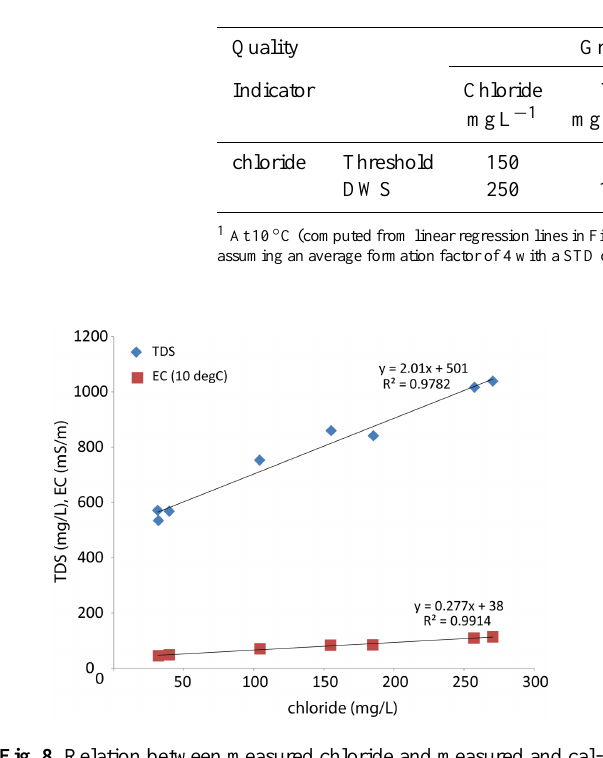
Table 8. Groundwater electrical conductivity (EC) and TDS content for the investigated chalk aquifer corresponding to the WHO and EU drinking water standard (DWS) for chloride of 250mgL − 1 , and a proposed threshold value for chloride of 150mgL − 1 (Hinsby et al., 2008).